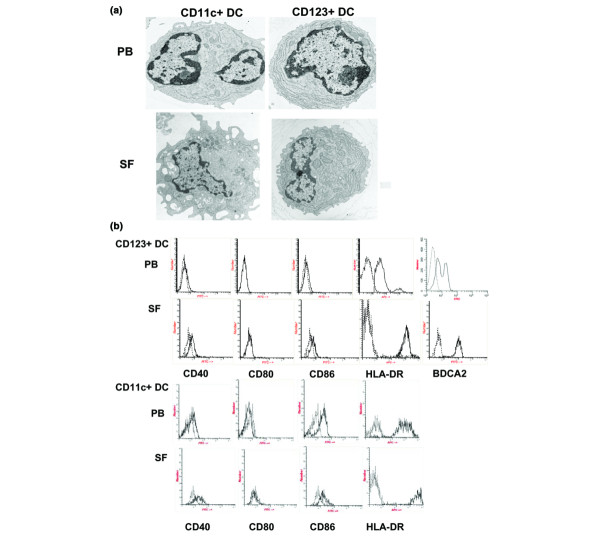
Morphology and cell-surface phenotype of dendritic cell (DC) subpopulations. (a) Freshly isolated CD11c+CD123- DCs and CD123+CD11c- DCs were sorted from either normal peripheral blood (PB) or rheumatoid arthritis (RA) synovial fluid (SF) according to the gating strategy outlined in the legend to Fig. 3 and were then prepared for transmission electron microscopy. Micrographs are representative of three separate donors. Scale bars represent 20 μm. (b) Normal PB or RA SF mononuclear cells were stained with CD123-PE, CD14-PECy5, HLA-DR-APC, and either isotype control or the depicted marker labelled with FITC. Live HLA-DR+CD14-CD123+ cells or HLA-DR+CD14-CD11c+ cells were gated; polymorphonuclear cells were excluded on the basis of forward and side light-scatter. The expression of isotype control (dotted lines) and indicated markers (continuous lines) by the gated cells are depicted. Data are from three donors of normal PB or RA SF. APC, antigen-presenting cell; PE, phycoerythrin.